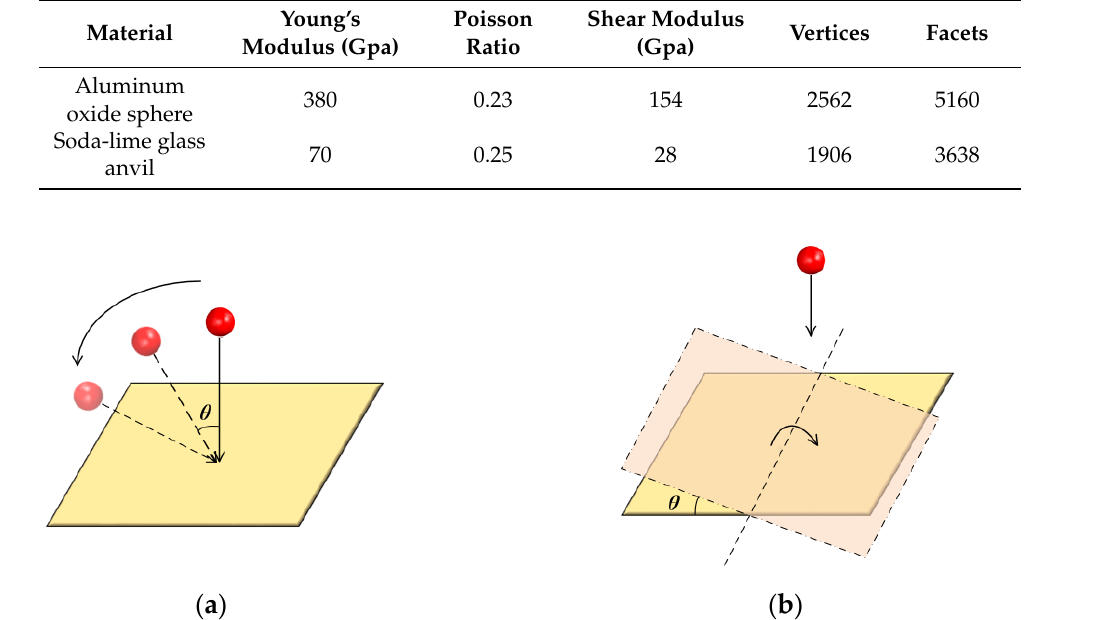
Figure 3. Illustration of the single-collision experiment. ( a ) oblique ingoing velocity; ( b ) rotation of the plane.